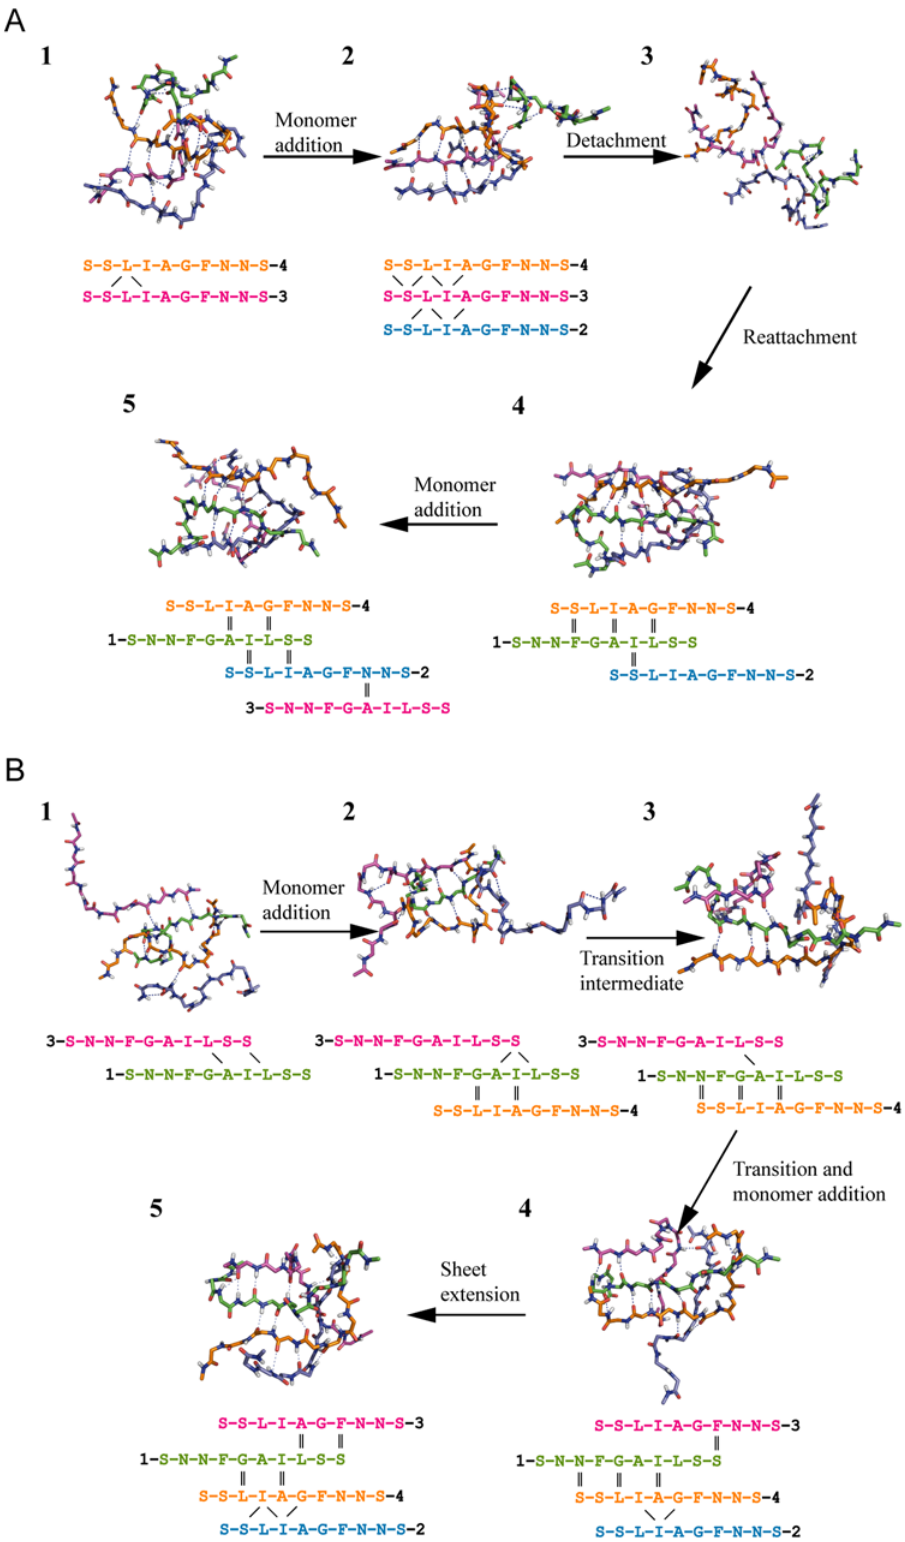
Figure 8. Two transition pathways illustrated by replica trajectories of hIAPP. (A). replica 2; (B). replica 20. Only main chain atoms of peptides are shown in sticks. Dashed blue lines indicate hydrogen bonds. Four strands are distinguished by different colors (strand 1, 2 3 and 4 is in green, blue, magenta and orange color, respectively). The alignment patterns are also sketched beneath corresponding snapshots. The strand numbers are labeled at the N-terminals. Hydrogen bonds involved in the predominant b -sheet regions are marked, with antiparallel hydrogen bonds labeled in double short lines, parallel hydrogen bonds labeled in forward/back slashes.